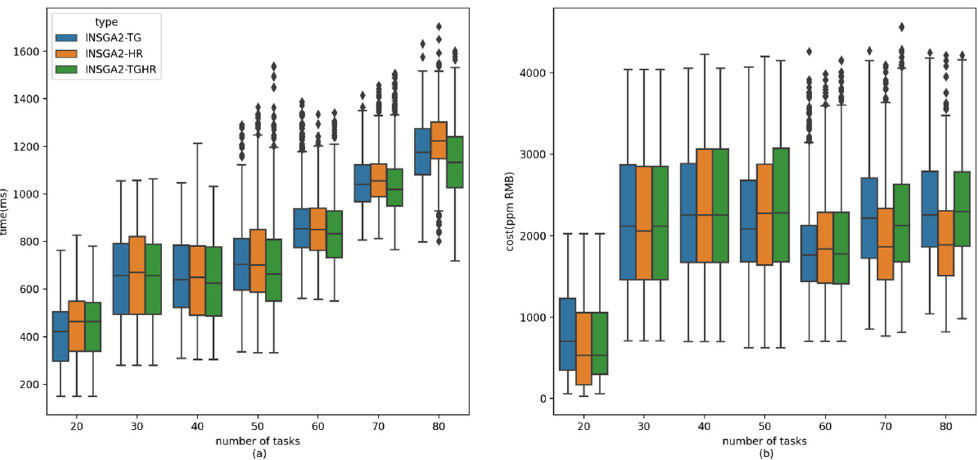
Figure 14. The boxplot in different number of tasks. ( a ) Comparing the effect of number of tasks on time; ( b ) Comparing the effect of number of tasks on cost.